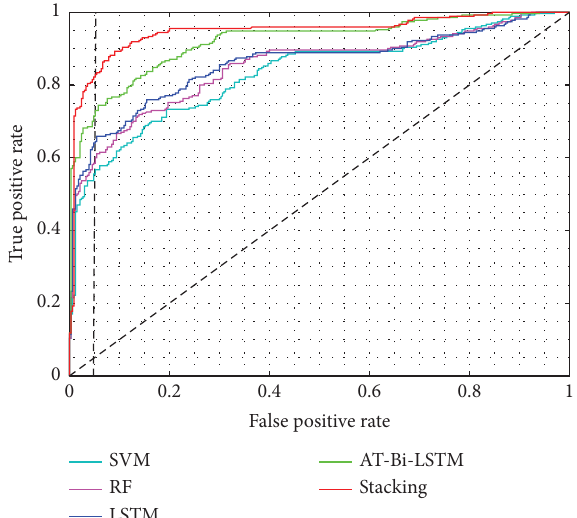
Figure 17: ROC curves of diferent models at 1s before crossing the zebra crossing.